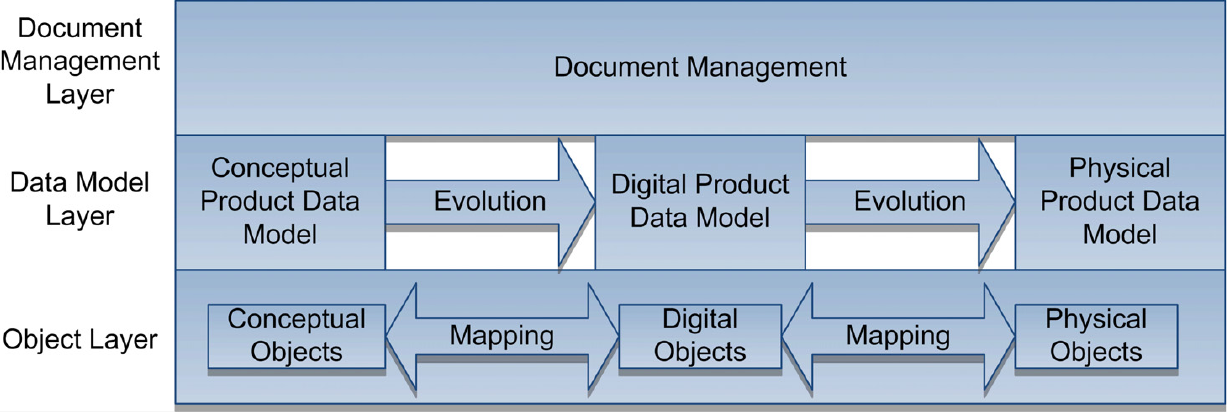
Figure 1. UDMPM Framework.